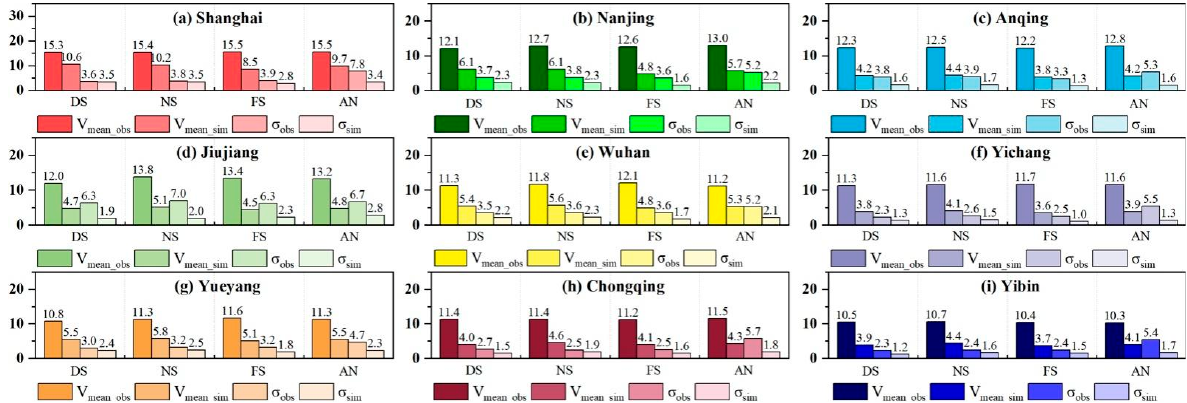
Figure 8. Mean ‒σ (Unit: m·s − 1 )comparison of seasonal scale (DS = dry season, NS = normal season, FS = flood season and AN = annual) mean of the maximum wind speed from observation and simulation for the two average 36-year intervals from 1979 ‒ 2014 and 2065 ‒ 2100 in 9 ports ( a ‒ i ).